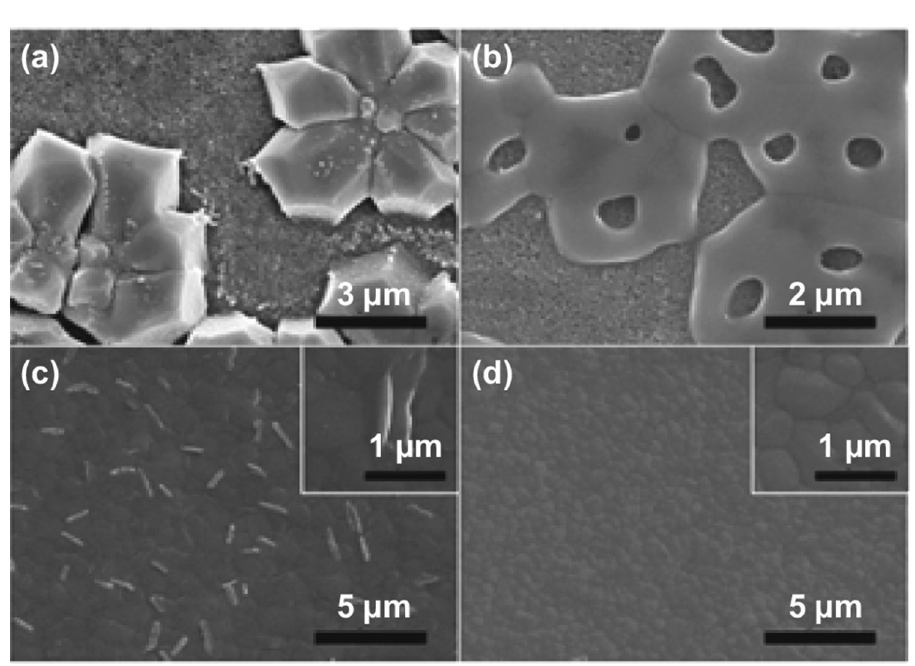
Fig. 22 SEM images of FASnI 3 perovskite film fabricated using N , N -dimethylformamide (DMF) solvent a without nonsolvent dripping and b with nonsolvent dripping; SEM images of FASnI 3 perovskite film fabricated using mixed solvent of DMF and dimethyl sulfoxide (DMSO) with nonsolvent dripping, c the absence of pyrazine and d the presence of pyrazine. Reproduced with permission Ref. [32]. Copyright (cid:2) 2016 American Chemical